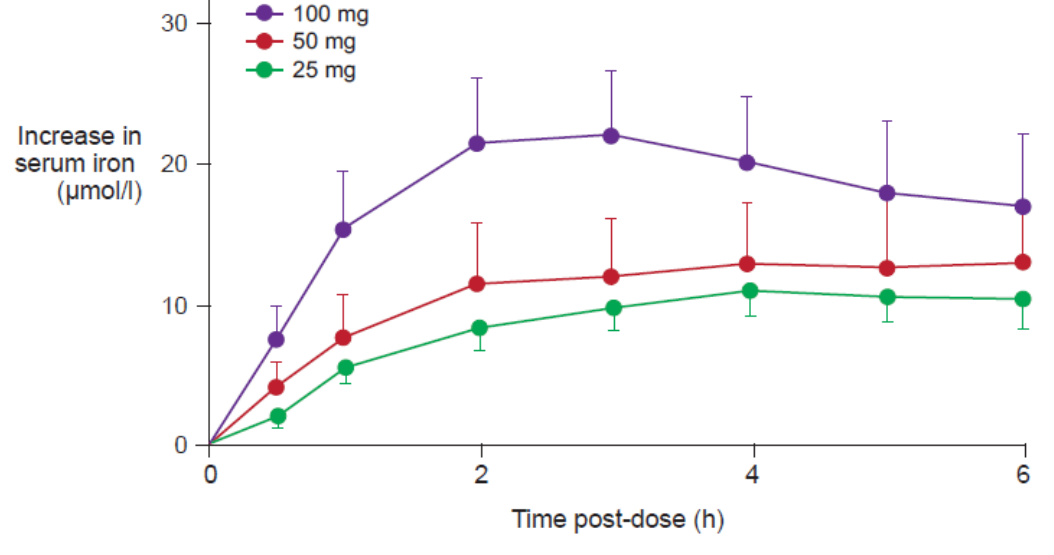
and AUC) and max